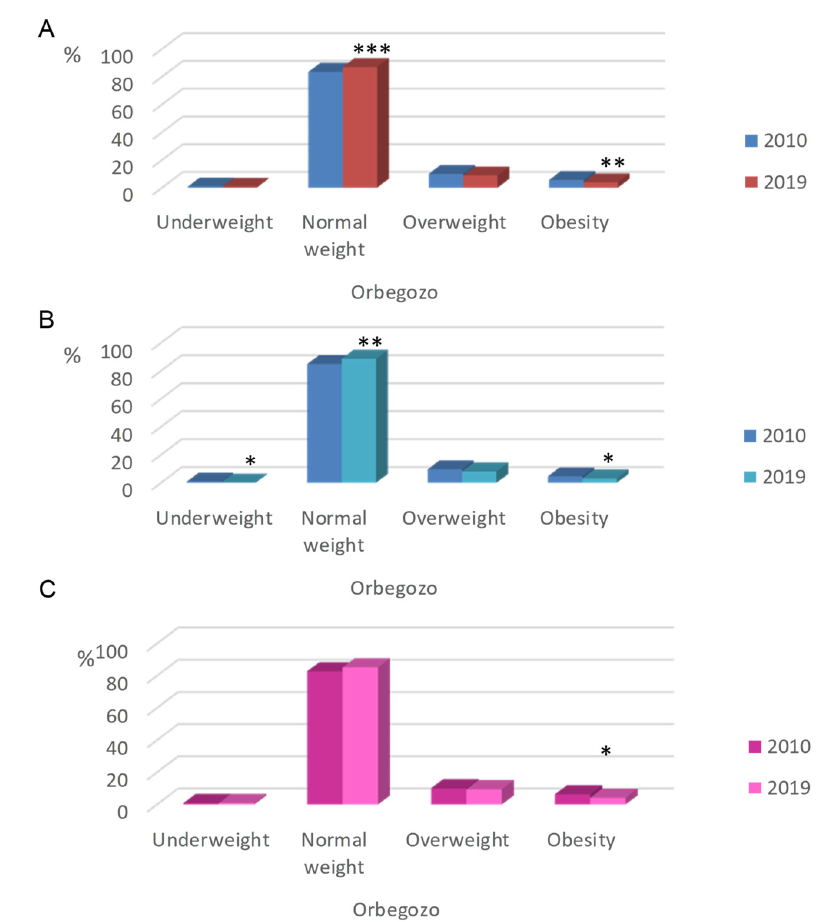
Figure 4. Prevalence of underweight, normal weight, overweight and obesity in Spanish children by Faustino Orbegozo Foundation (OF) reference values. ( A ) Total population. ( B ) Boys. ( C ) Girls. * p ≤ 0.05 vs. year 2010 (Chi-Square test); ** p ≤ 0.01 vs. year 2010 (Chi-Square test); *** p ≤ 0.001 vs. year 2010 (Chi-Square test).